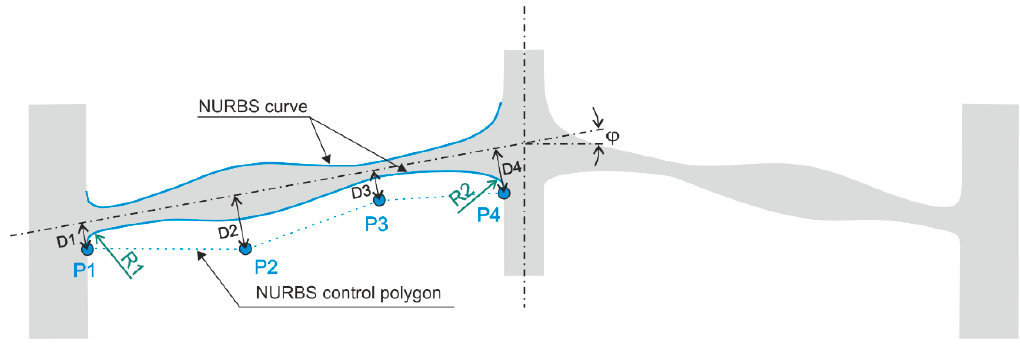
Figure 11. Geometry and parametrization of the model.